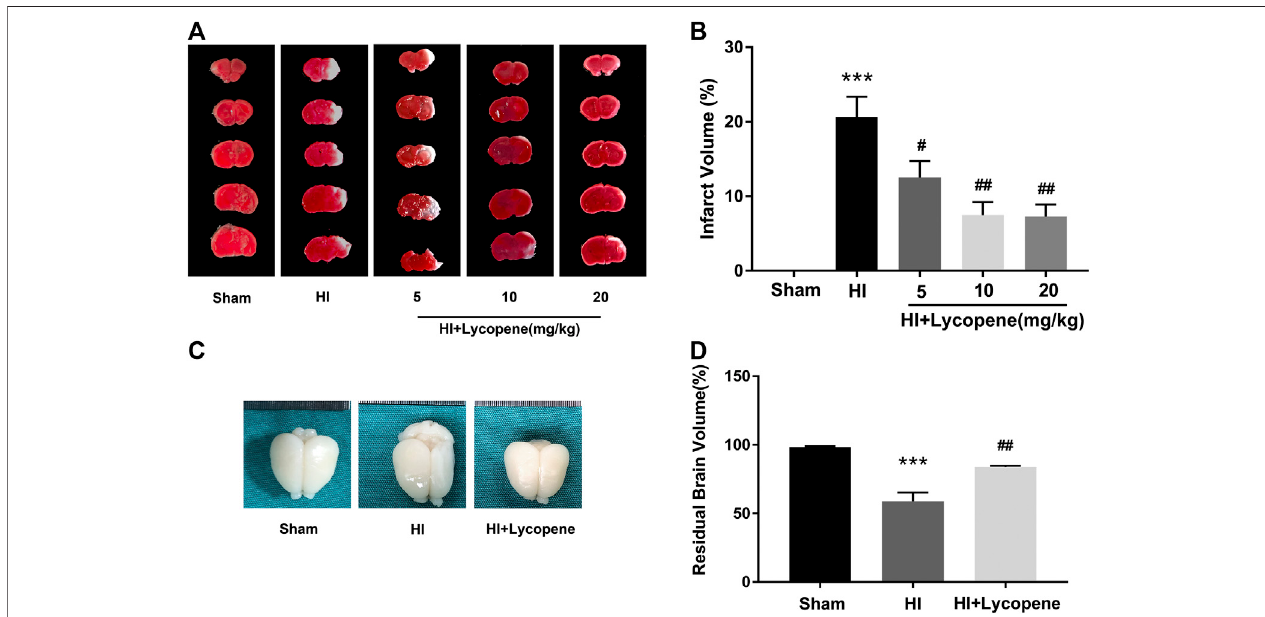
FIGURE 1 | Lycopene treatment attenuated hypoxic-ischemic (HI) brain injury in neonatal rats. (A) Representative images of 2,3,5-triphenyl tetrazolium chloride (TTC) staining of coronary brain one day after HI injury. n (cid:2) 5. (B) Analysis of infarct volume based on TTC staining. *** p < 0.001 vs. the sham group, # p < 0.05 and ## p < 0.01 vs. the HI group. All data are presented as mean ± SEM, n (cid:2) 5. (C) Representative images of the brain from each group 7 days after HI injury. n (cid:2) 6. Scale bar (cid:2) 1 mm. (D) Theratiooftheinjuredhemispheretocontralateralhemisphereisde fi nedasresidualbrainvolume.*** p < 0.001vs.theshamgroup. ## p < 0.01vs.theHI group. All data are presented as mean ± SEM, n (cid:2)